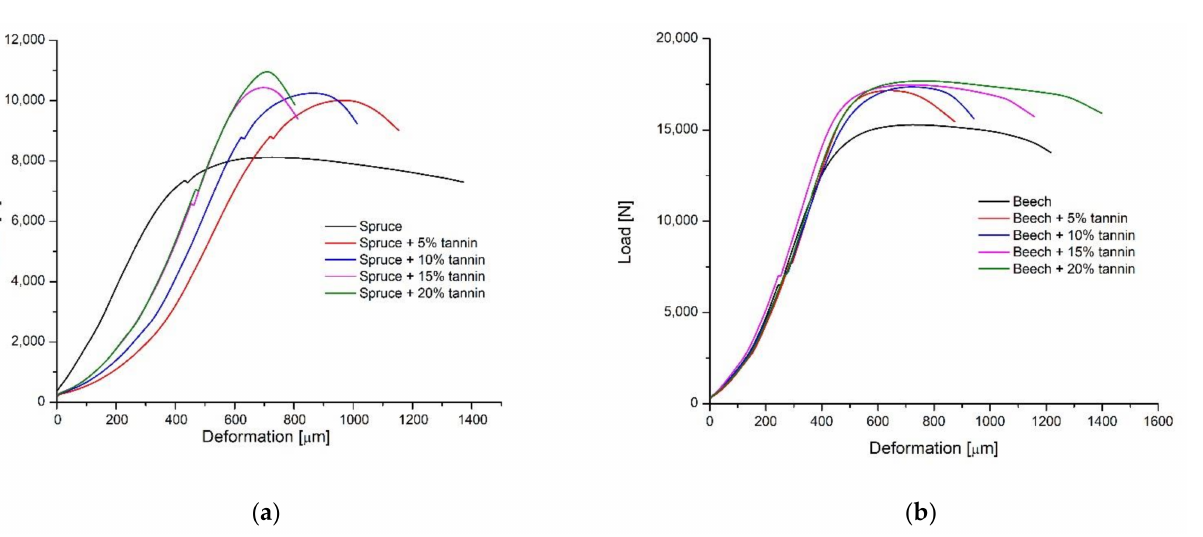
Figure 4. Compression resistance behavior of spruce ( a ) and beech ( b ) treated with different concen- trations of tannin–hexamine